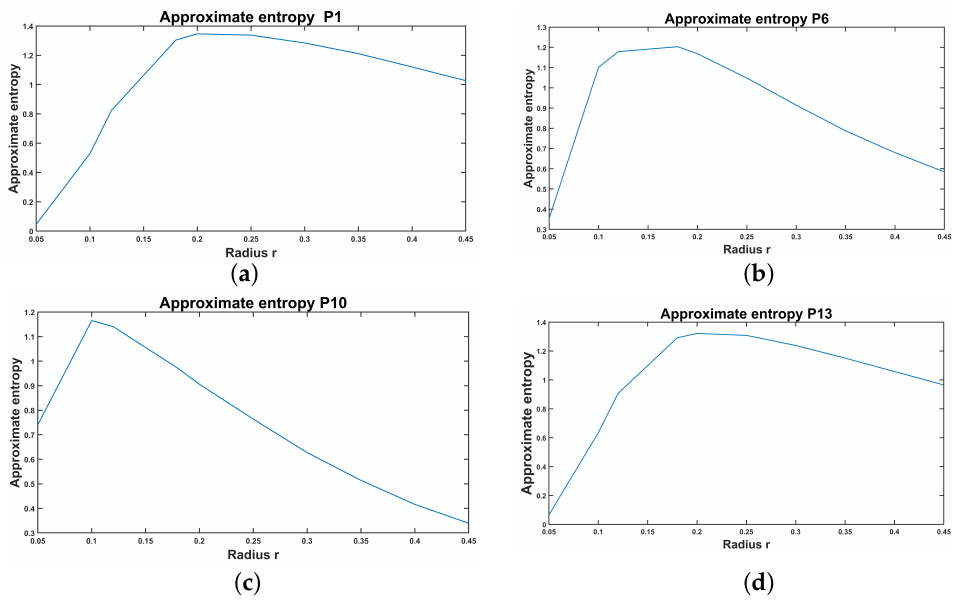
Figure 4. AppEn for several signals from the pump dataset. ( a ) ApEn for a signal from class P1, ( b ) ApEn for a signal from class P6, ( c ) ApEn for a signal from class P10, ( d ) ApEn for a signal from class